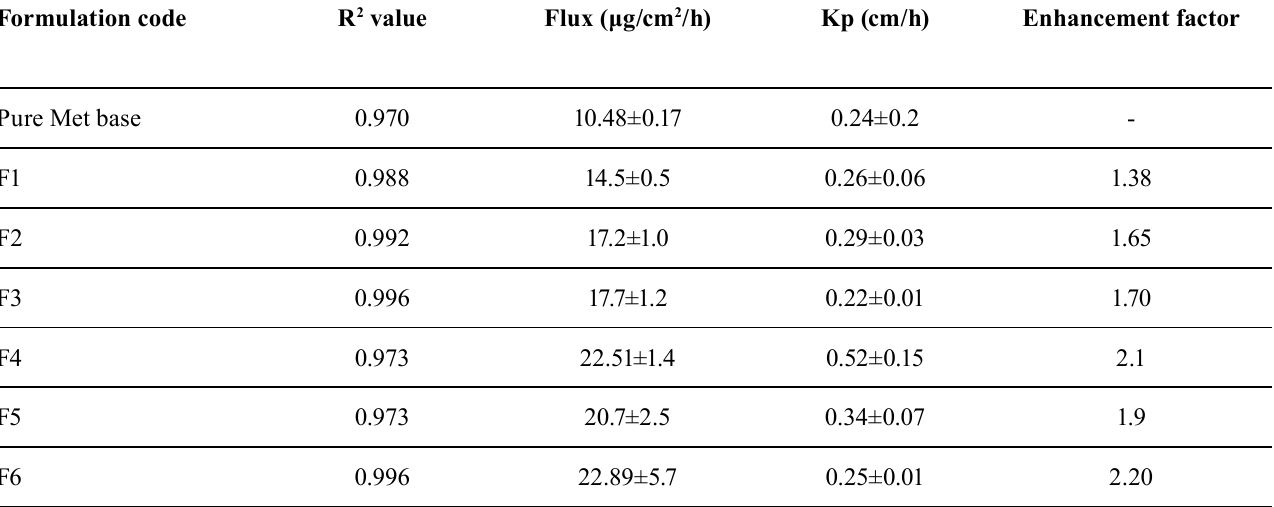
R 2 =Coefficient of determination according to zero order kinetics, Kp= permeation